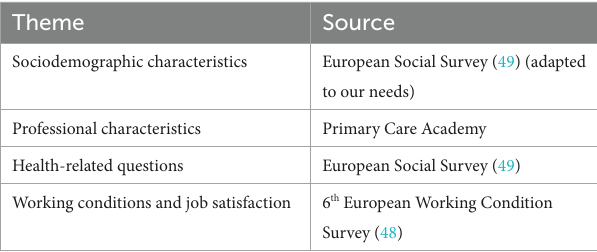
TABLE 9 Overview of scales to measure sociodemographic characteristics, professional characteristics, health-related questions, working conditions and job